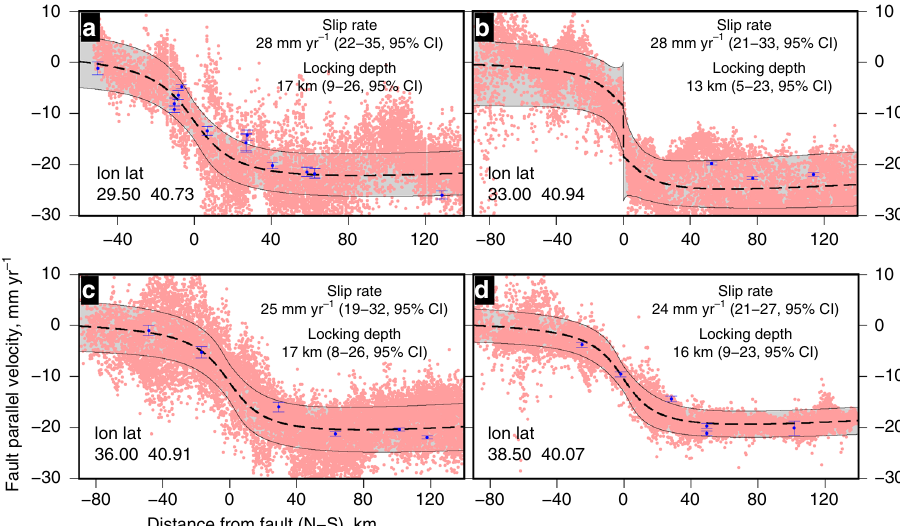
Fig. 2 Estimating fault parameters from velocity pro fi les. A selection of pro fi les ( a – d ) used to estimate the fault slip rate and locking depth (red points in Fig. 3) along the North Anatolian Fault. All 22 pro fi les are shown in Supplementary Fig. 6. The red points are the fault parallel component of the horizontal velocity fi eld projected from within 25 km perpendicular distance onto each pro fi le. The blue points are the fault parallel component of the GNSS velocities. The black dashed line is our maximum a posteriori probability (MAP) solution with the grey shaded area representing the 95% con fi dence